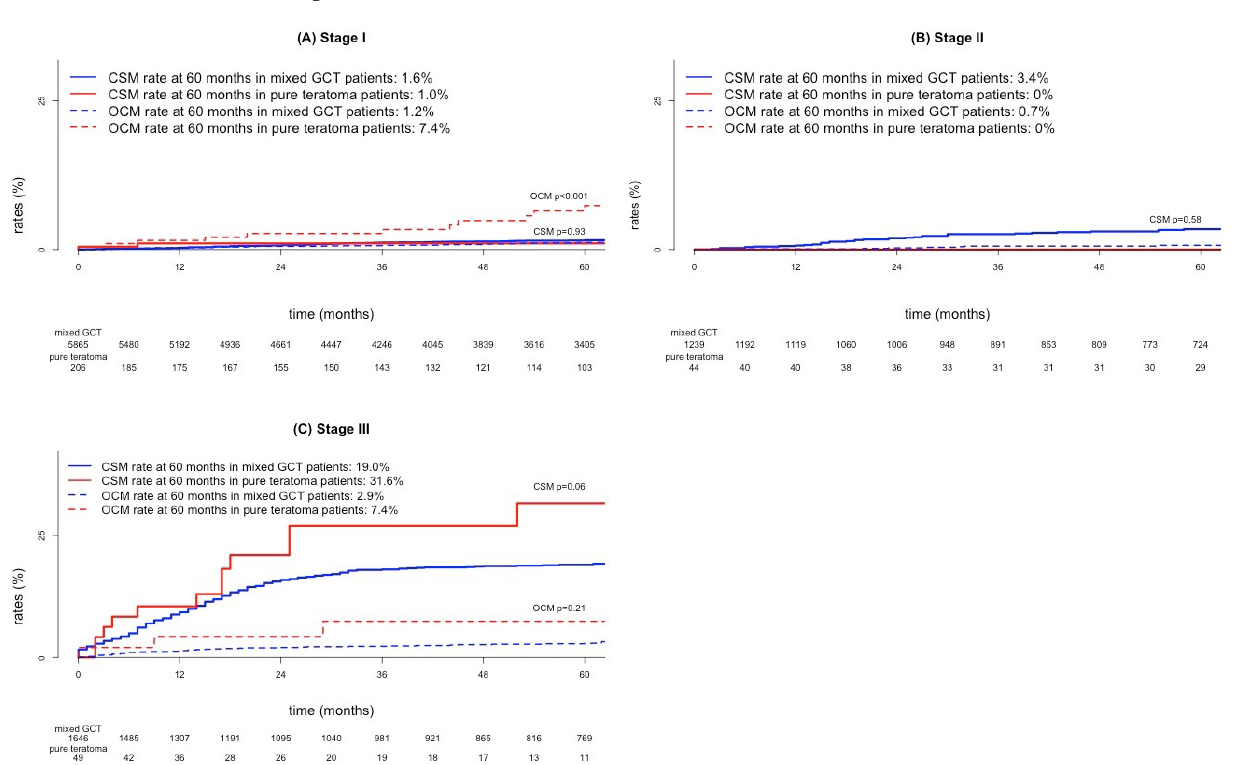
Figure 3. Cumulative incidence plots depicting cancer-specific mortality (CSM) and other-cause mortality (OCM) rates in patients with pure teratoma and mixed germ cell tumor (GCT) according to ( A ) stage I, ( B ) stage II and ( C ) stage III. ( A ) stage I, ( B ) stage II and ( C ) stage